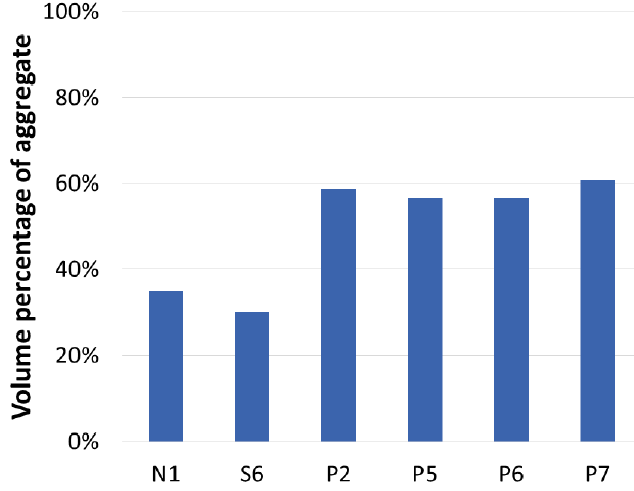
Figure 6. The volume fraction of lightweight aggregates in each